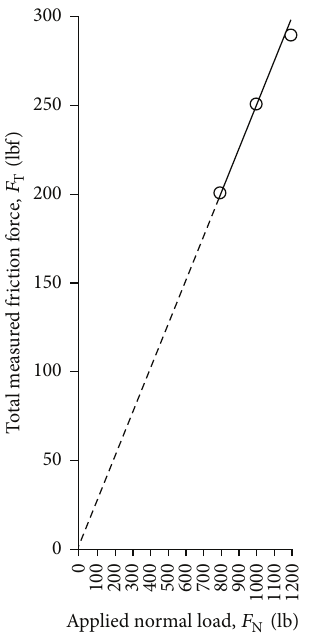
Figure 2: Checking for the existence and accuracy of the 150 lbf microhysteretic friction force, 𝐹 Hs , by extrapolation of the TRB data points to the origin.